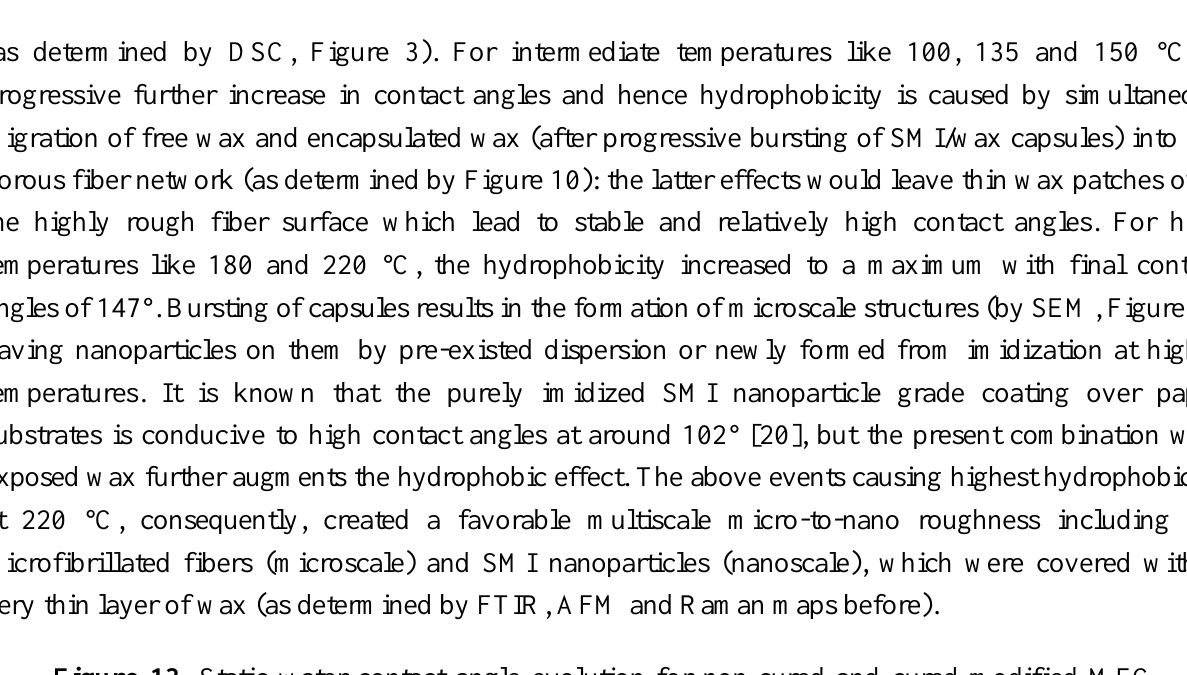
Figure 13. Static water contact angle evolution for non-cured and cured modified MFC films after curing at different temperatures for 2